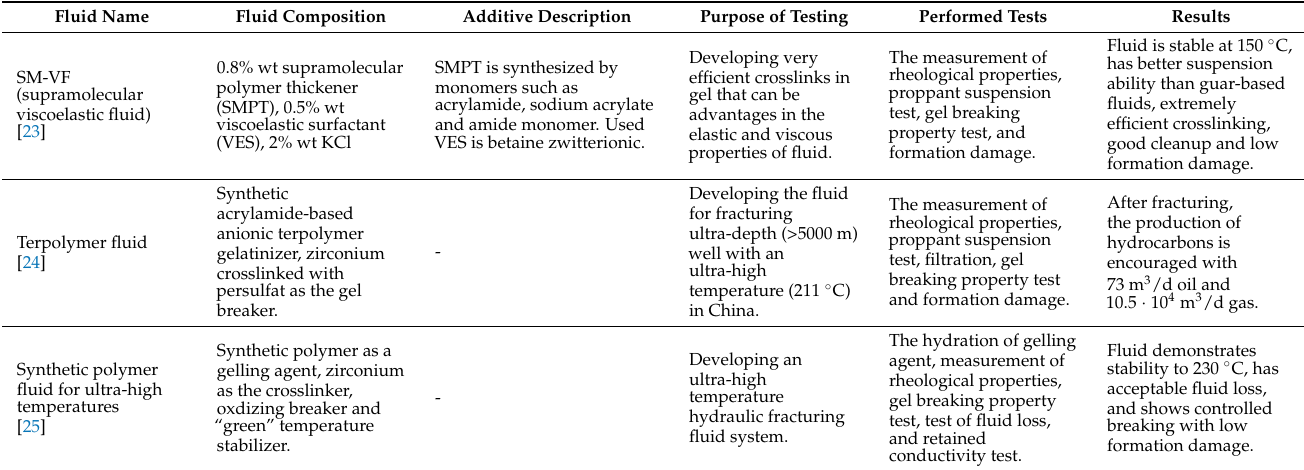
Table 11. Newly developed synthetic fracturing